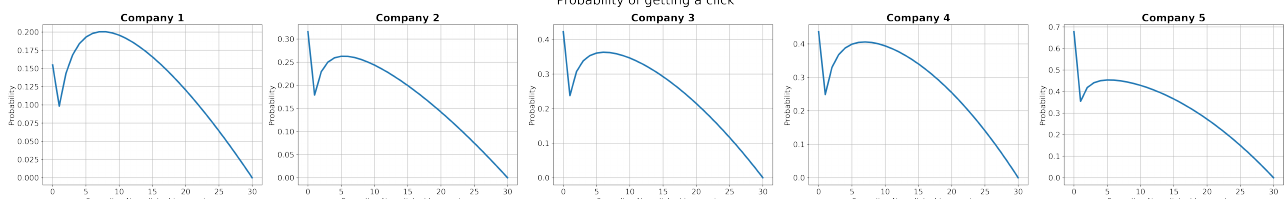
Figure 8. The figure shows the maximum probability of getting the first click of each client using the upper bound click rate approximation for each of them and under the assumption that the FC is